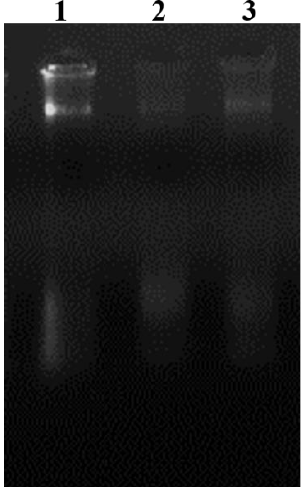
Figure 9. Agarose gel electrophoresis analysis of genomic DNA in R. solanacearum treated with DAPG and tetracycline. Lane 1: control; 2: tetracycline; and 3: DAPG.